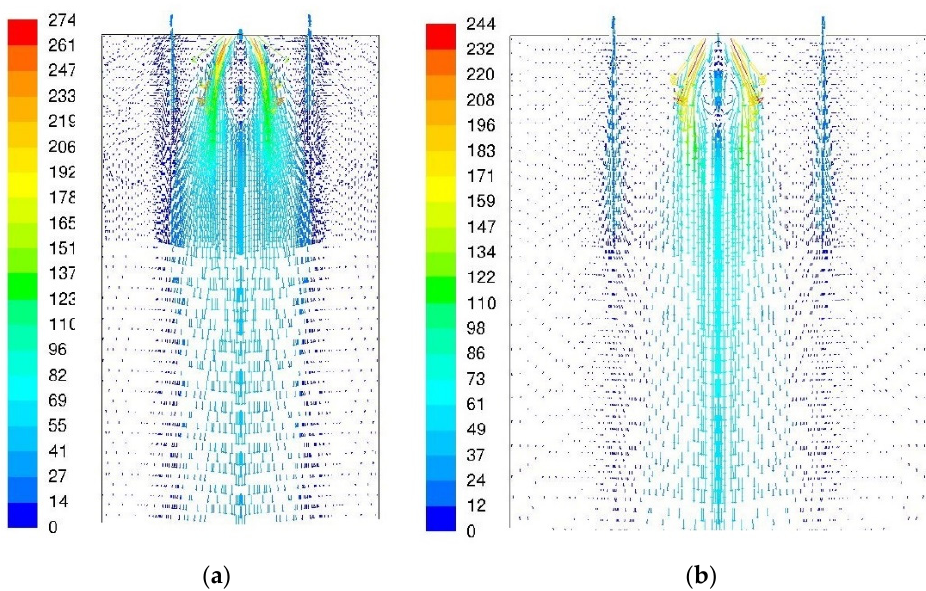
Figure 11. Velocity vector field in the plane passing through the centers of two powder feeding ports: ( a ) design No. 1 and